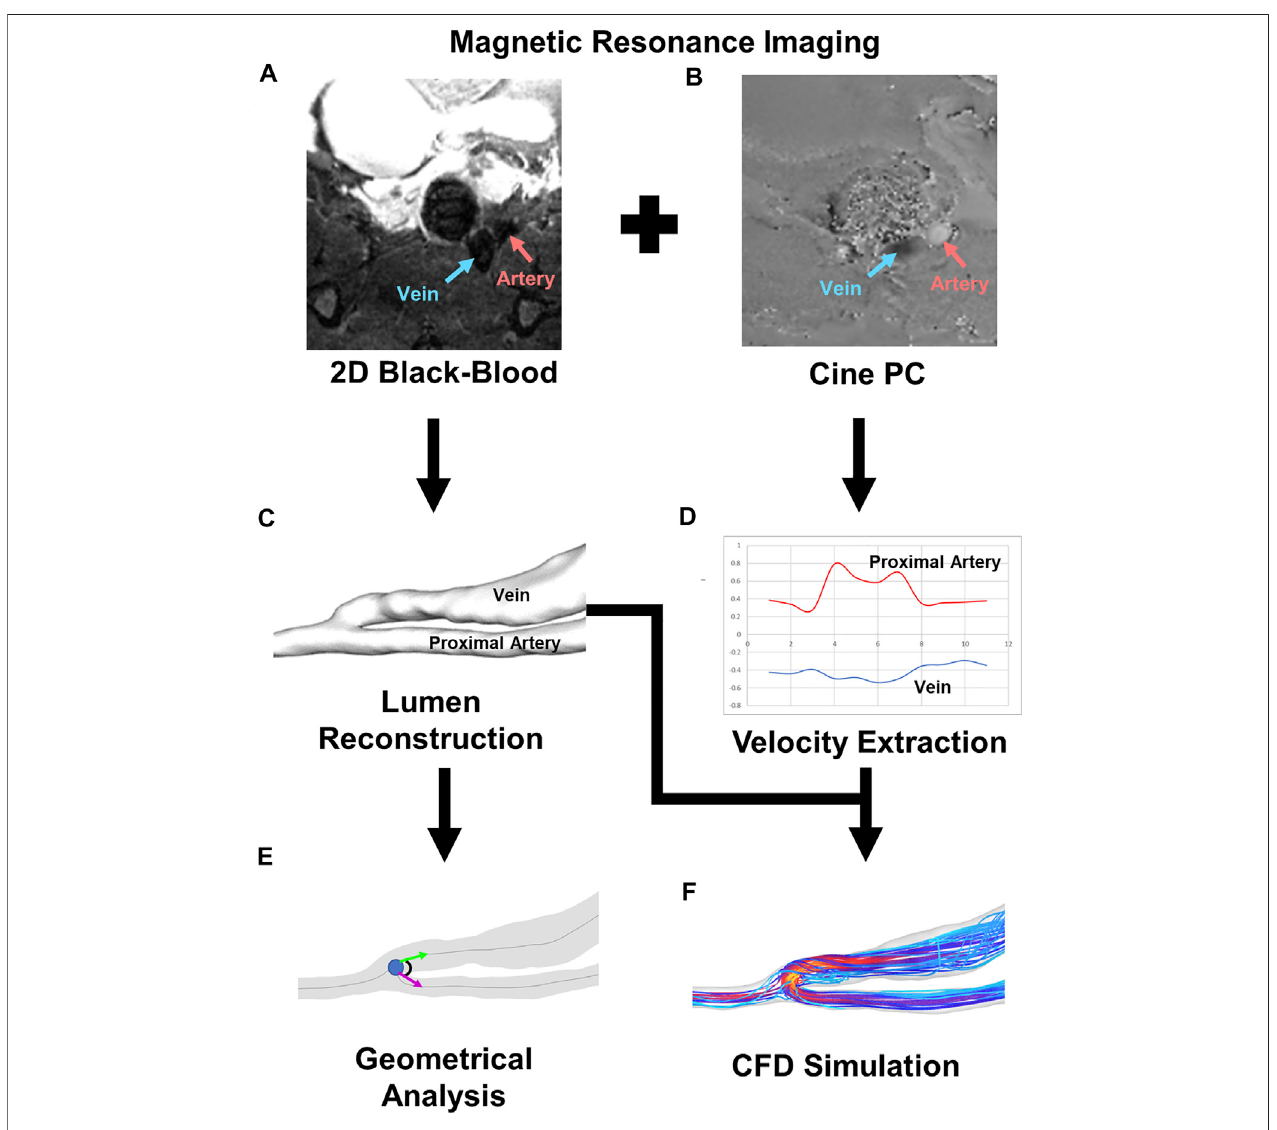
FIGURE1| PipelineforCFDandgeometricalanalysis. (A) 2Dblack-bloodMRIimageforAVFlumengeometryvisualization.Redandbluearrowspointtotheartery and vein, respectively. (B) Cine-phase contrast image for velocity mapping. Red and blue arrows point to the artery and vein, respectively. (C) Representative image of lumenreconstructioncreatedfromblack-bloodMRI. (D) Representativegraphofvelocityextractedfromcine-phasecontrastimage.Redrepresentstheproximalartery, and blue represents the fi stula vein. (E) Representative image of geometrical analysis for anastomosis angle. (F) Representative image of velocity streamlines from CFD